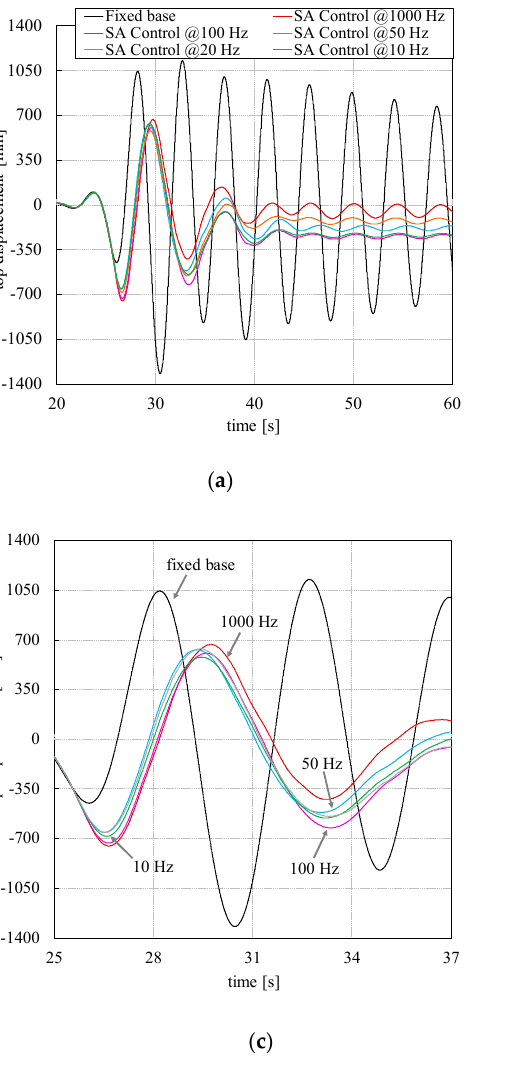
Figure 6. ( a ) Displacement and ( b ) stress response for different frequencies of measures for control, ( c ) zoom of panel (a), ( d ) zoom of panel (b). Table 4. Range of demand reduction against the three load cases for the range 10-1000 Hz of SA control